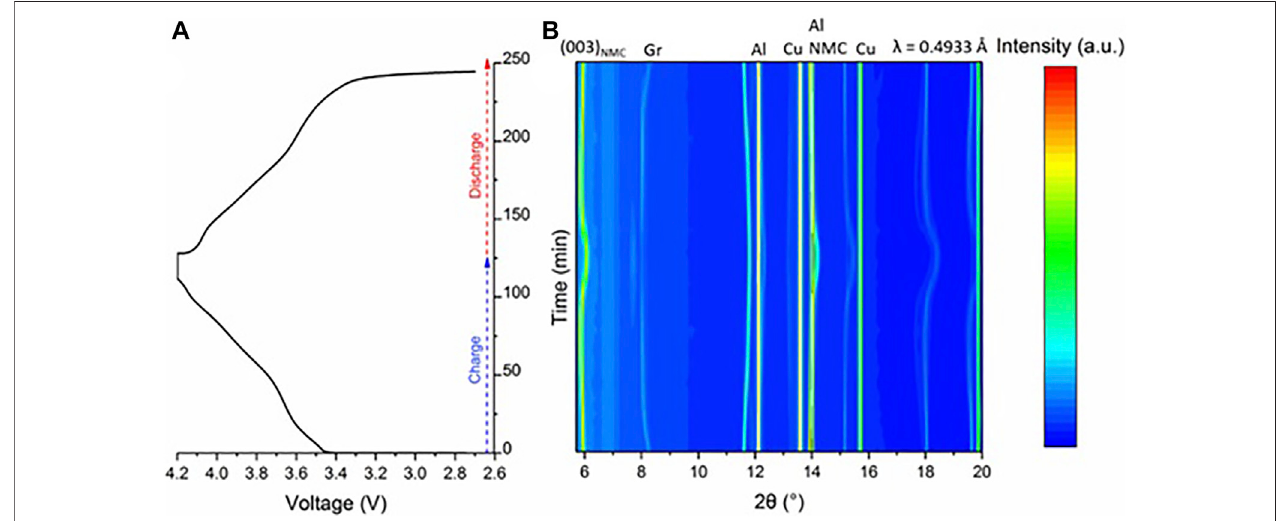
FIGURE 2 | (A) Charge – discharge curve of the pristine cell, in the cell holder during operando measurement at a rate of 0.5 C followed by a constant voltage hold untilthecurrentwas0.05 C. (B) SXRDpatternsfor2 θ rangeof5 – 20forthecharge – dischargeshowpart (A) atPosition5,centerofthecellasillustratedin Figure1 .The colors indicate x-ray intensity, with blue the lowest and red the